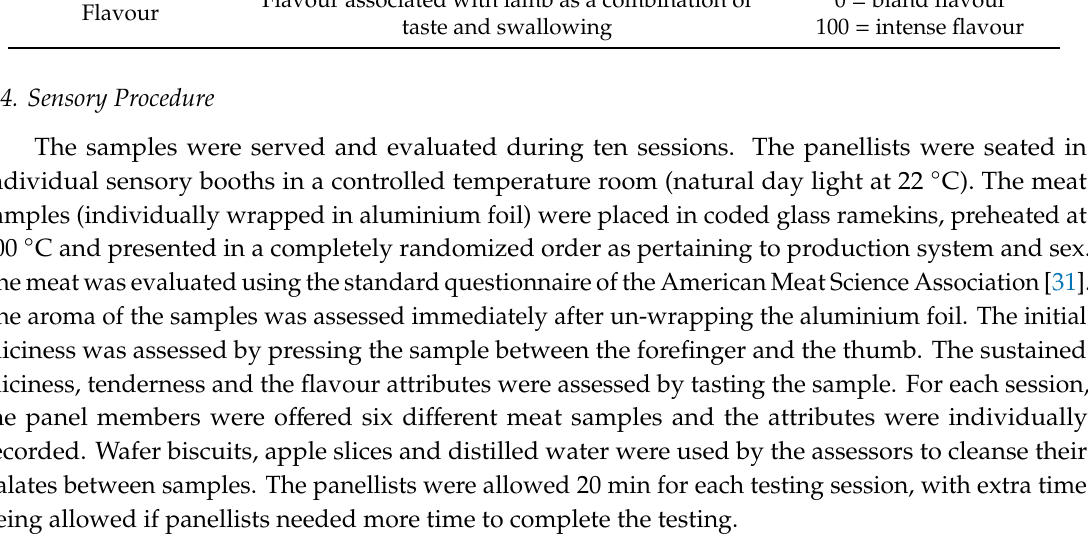
Table 1. Verbal definitions used to describe the sensory attributes of the Dorper lamb. Attribute Definition Scale Lamb aroma Aroma associated with lamb The amount of fluid that exudates on the cut surface Initial juiciness when pressed between thumb and fore finger The degree of juiciness perceived after the first two to Sustained juiciness three chews between the molar teeth Impression of tenderness after the first two to three Tenderness chews between the molar teeth Flavour associated with lamb as a combination of Flavour taste and